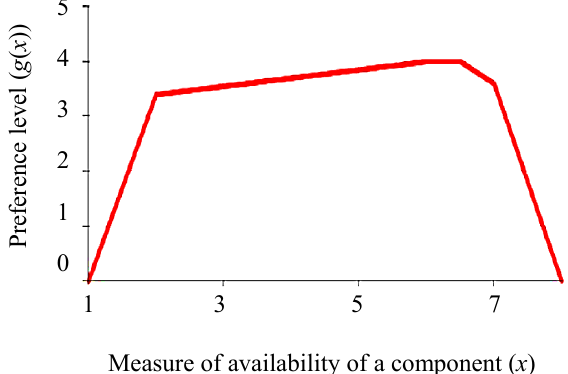
However, in some cases, not only the interval of changes in its possible values, but also the most desirable value of the indicator or its interval can be indicated for the loss indicator. In this case, instead of the trapezoidal membership function, it is proposed to use its modification, taking into account the specified additional condition (Fig. 3).